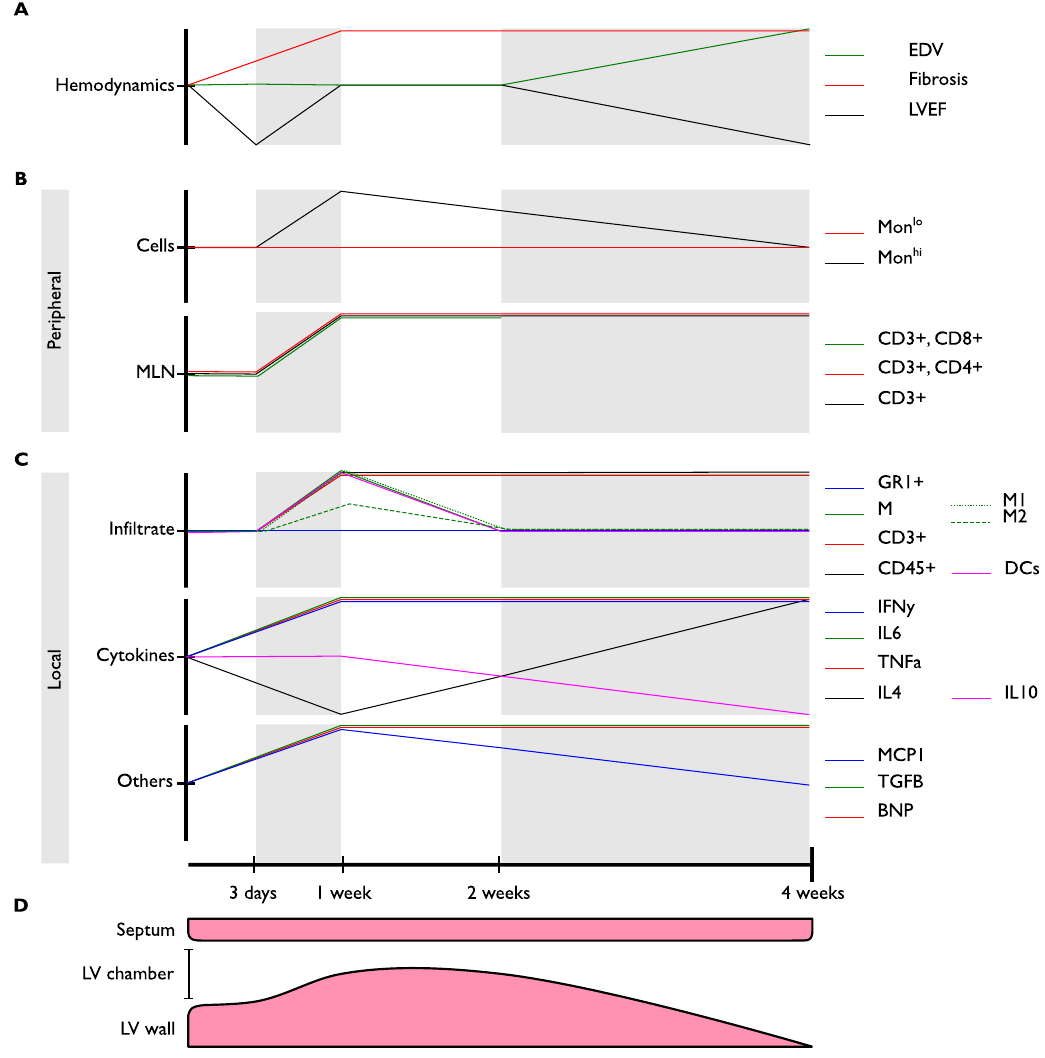
Figure 2. Graphical representation of changes through time in PO-HF. This figure is divided vertically in four panels ( A to D ) representing different groups of parameters evaluated; each panel has at its right end, the color code that represents each color line; and along the X-axis at the bottom, a timeline can be observed representing critical time frames for the PO-HF model. The graphical values plotted represent significant changes for increased or decreased values compared with their respective control group at the same moment of measurement. ( A ) Hemodynamic parameters. ( B ) Peripheral cell populations. ( C ) Heart tissue measurements. ( D ) Thickness of LV wall and dimensions of LV chamber. X-axis represents time. Y-axis is divided into a different set of measured parameters. Values represent significant changes for increased or decreased values compared with control groups. MLN: Mediastinal lymph nodes; EDV: End diastolic volume; LVEF: Left ventricle ejection fraction; Mon: Monocytes; M: Macrophages; M1: Pro-inflammatory macrophages; M2: Anti-inflammatory macrophages; DCs: Classical dendritic cells; BNP: Brain natriuretic